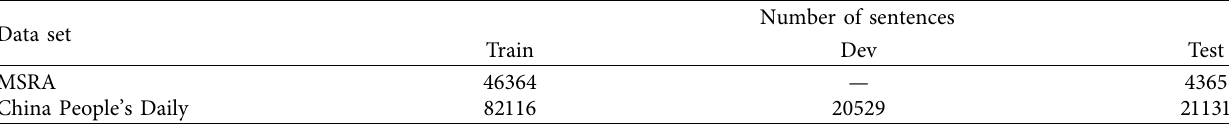
Table 2: Dataset statement summary